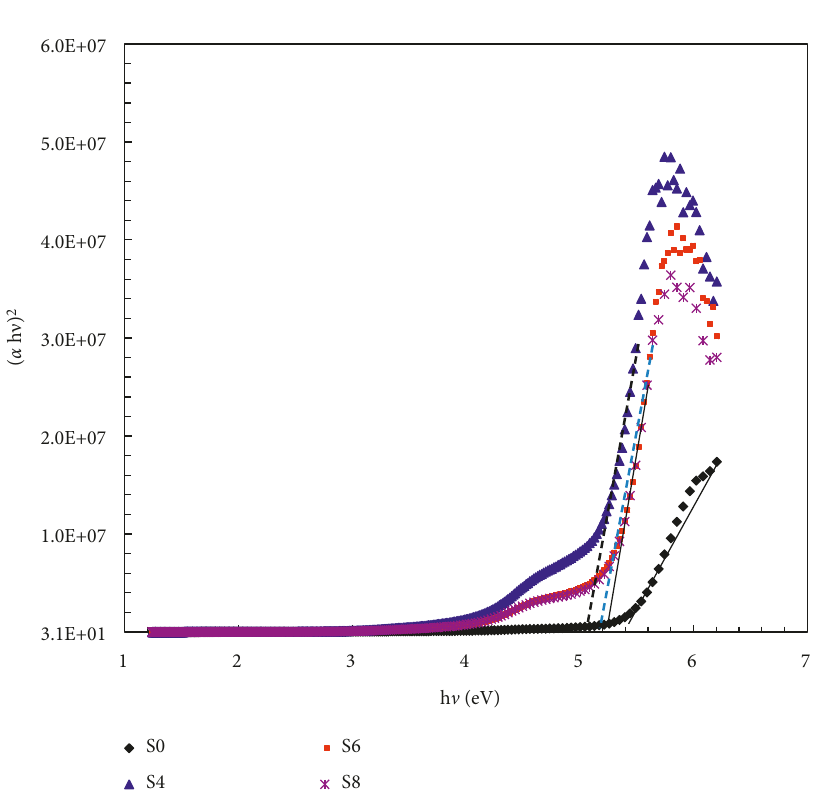
Figure 7: Tauc’s plot of CuONPs-doped HEC